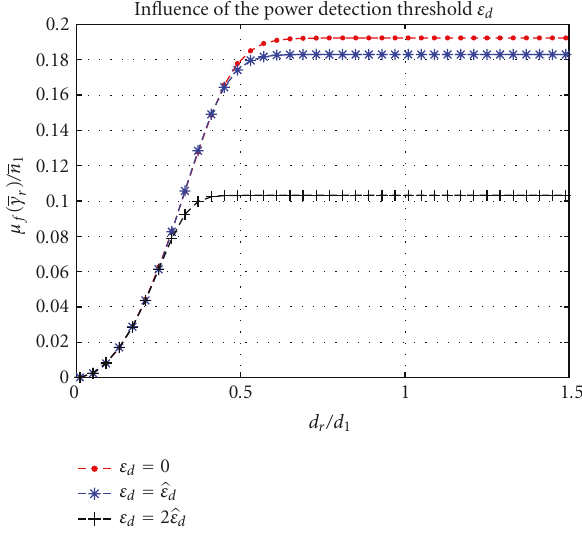
Figure 11: Related mean node degree in Nakagami- m , m = 10, channels for di ff erent ε d as function of the reliability range d r ( α =